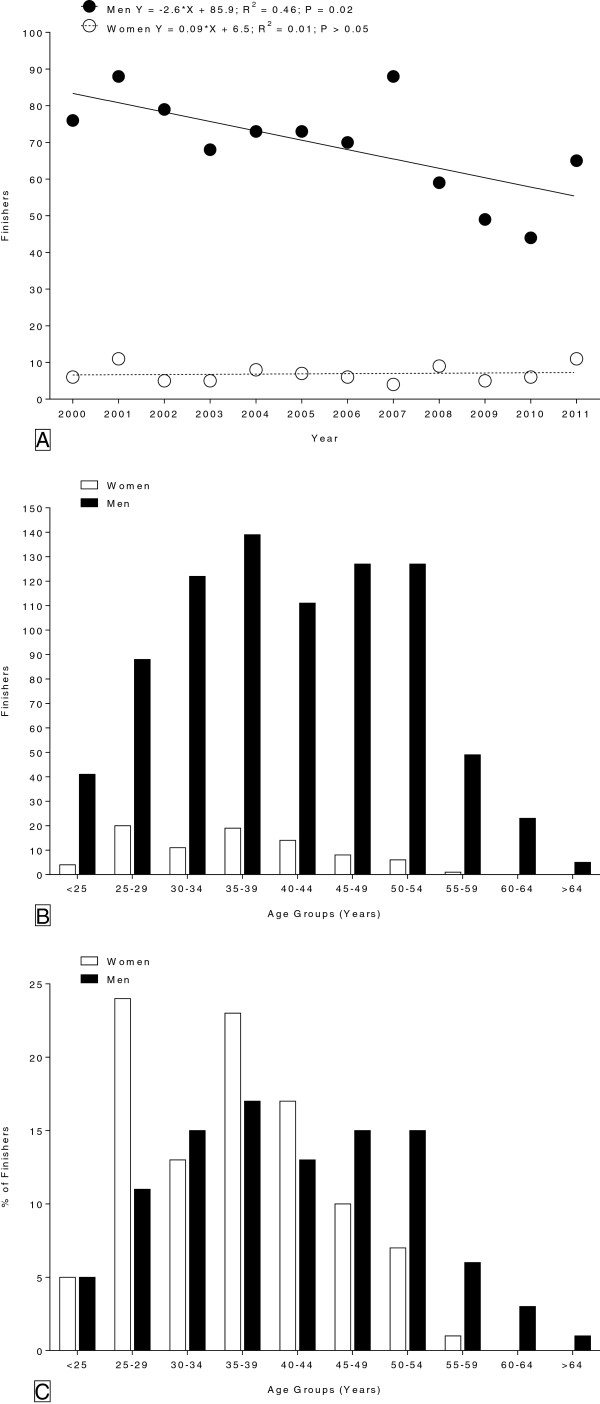
Number of female and male finishers in the ’24 Stunden Schötz’ from 2000 to 2011 (Panel A), number of female and male finishers for each age group (Panel B) and number of finishers for each age group expressed in percent of all finishers (Panel C).